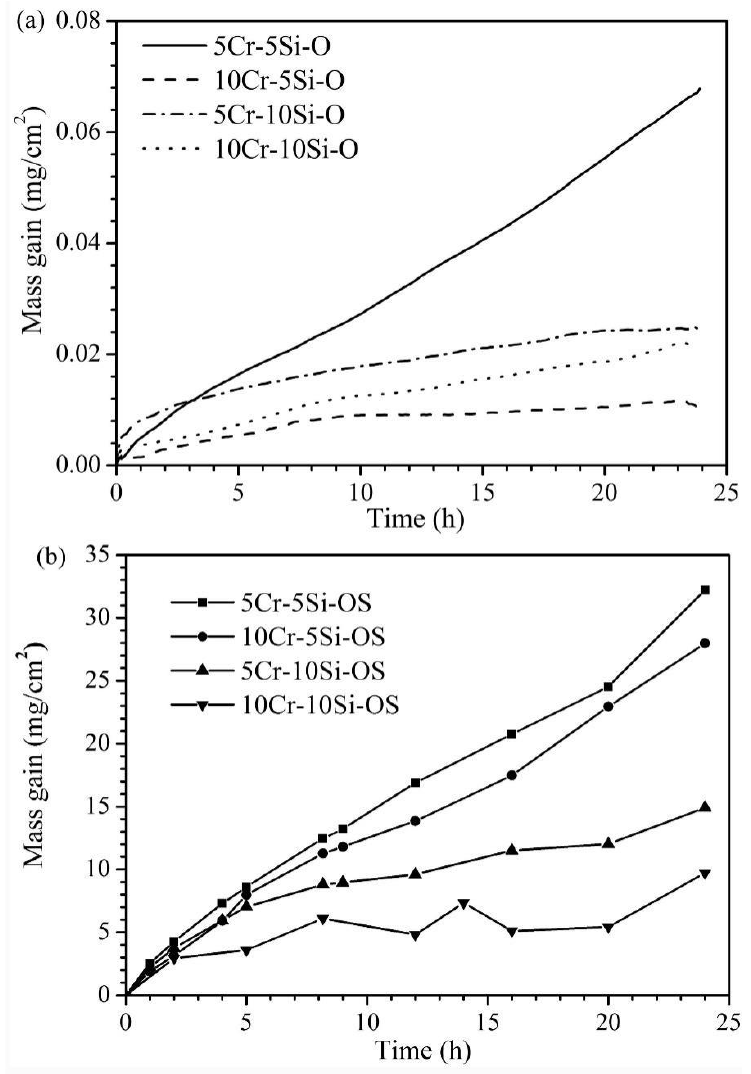
Figure 3. Kinetic curves for the Fe-xCr-ySi (x = 5, 10, y = 5, 10) corroded in H 2 -CO 2 ( a ) and H 2 -CO 2 - H 2 S mixture ( b ) at 600 °C for 24